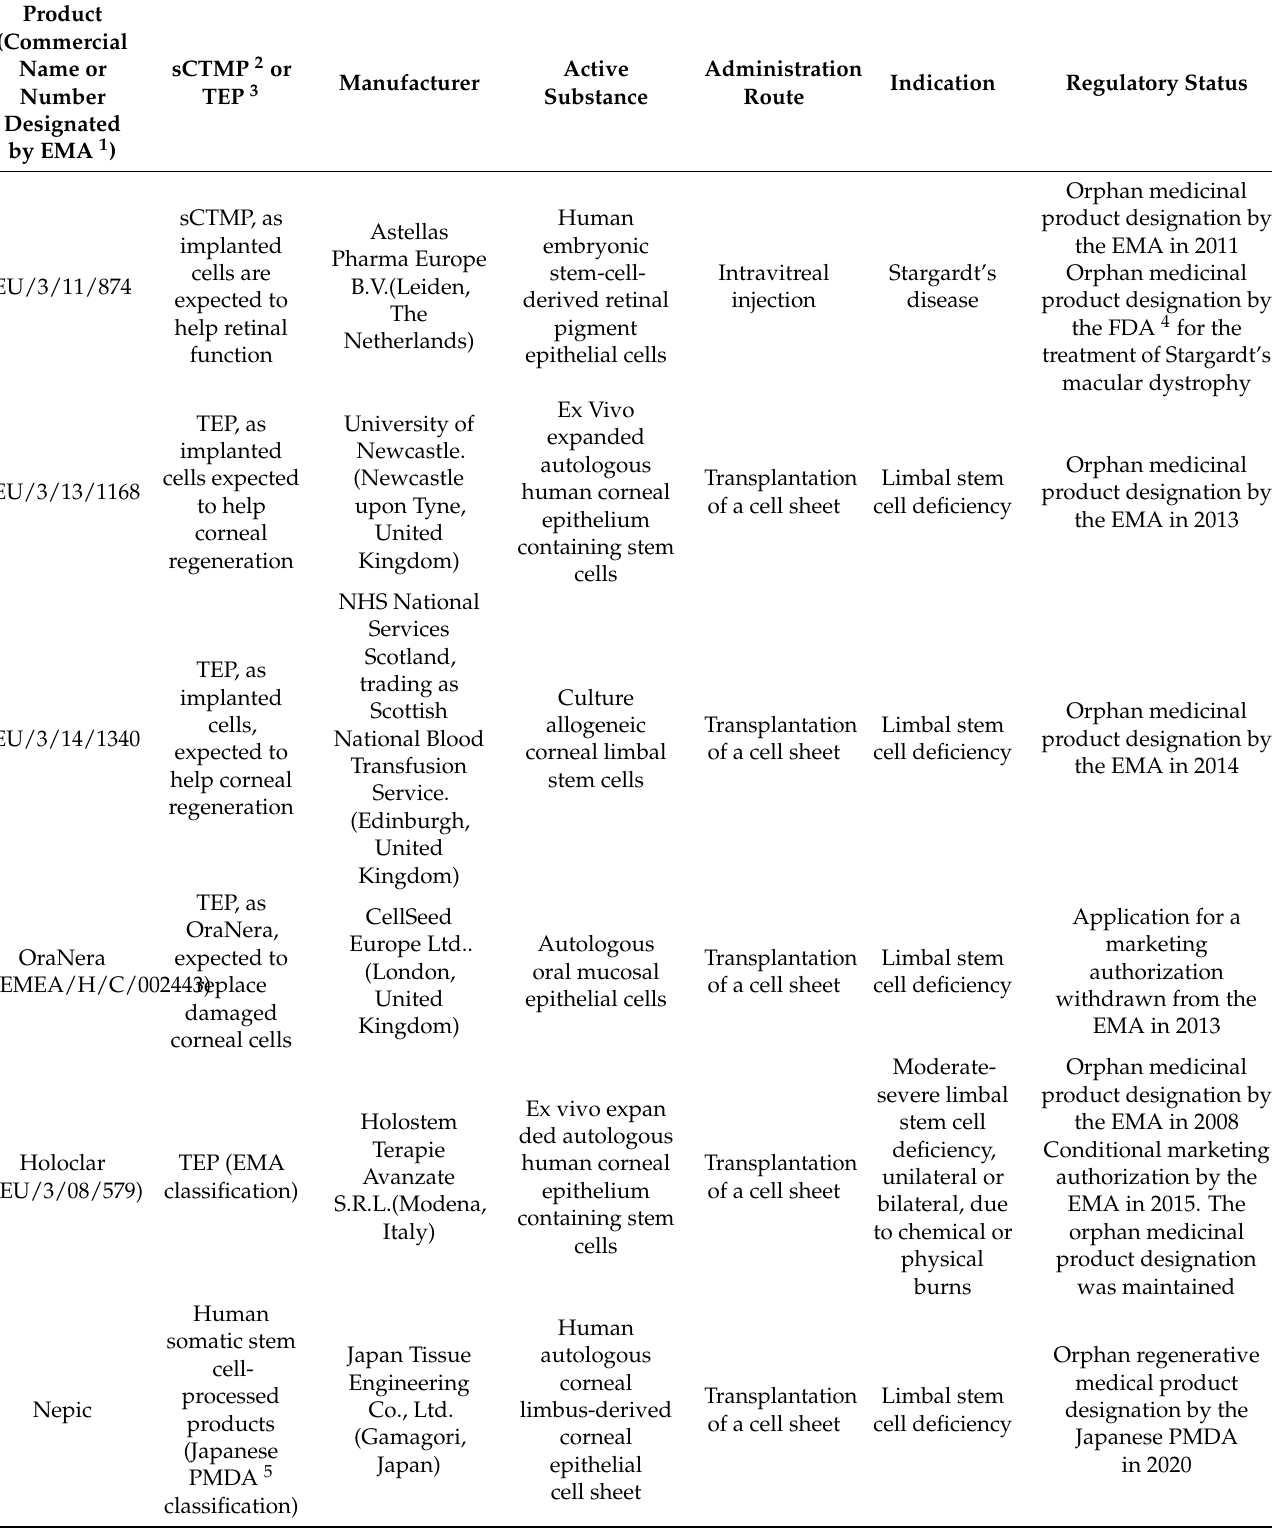
Table 2. Somatic cell therapy and tissue engineering medicinal products for the